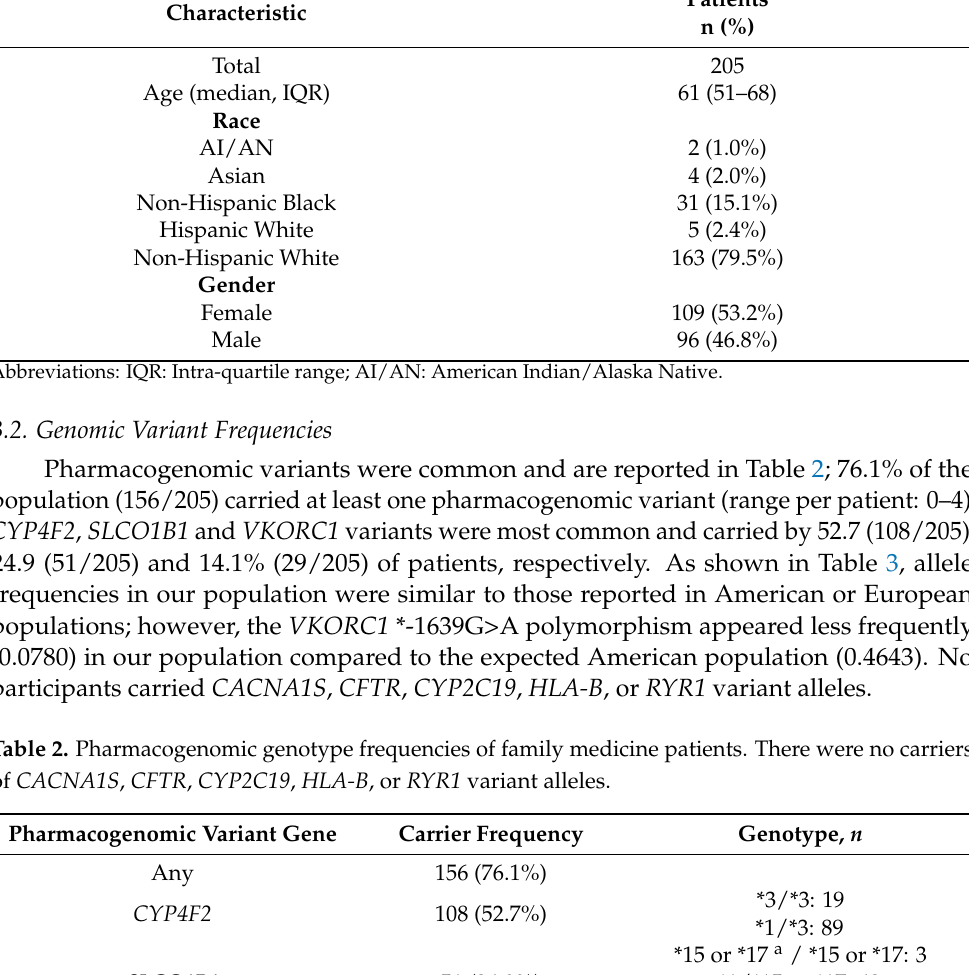
Figure 1. Study flow diagram. Table 1. Demographic characteristics of family medicine patients.